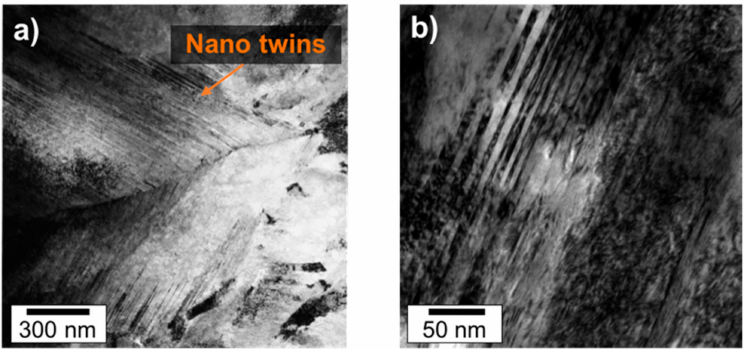
Figure 3. ( a ) Bright-field micrographs of the intersection of two martensitic twin domains separated by a twin midrib in 100Cr6 steel in the as-quenched state; and ( b ) nano twins in